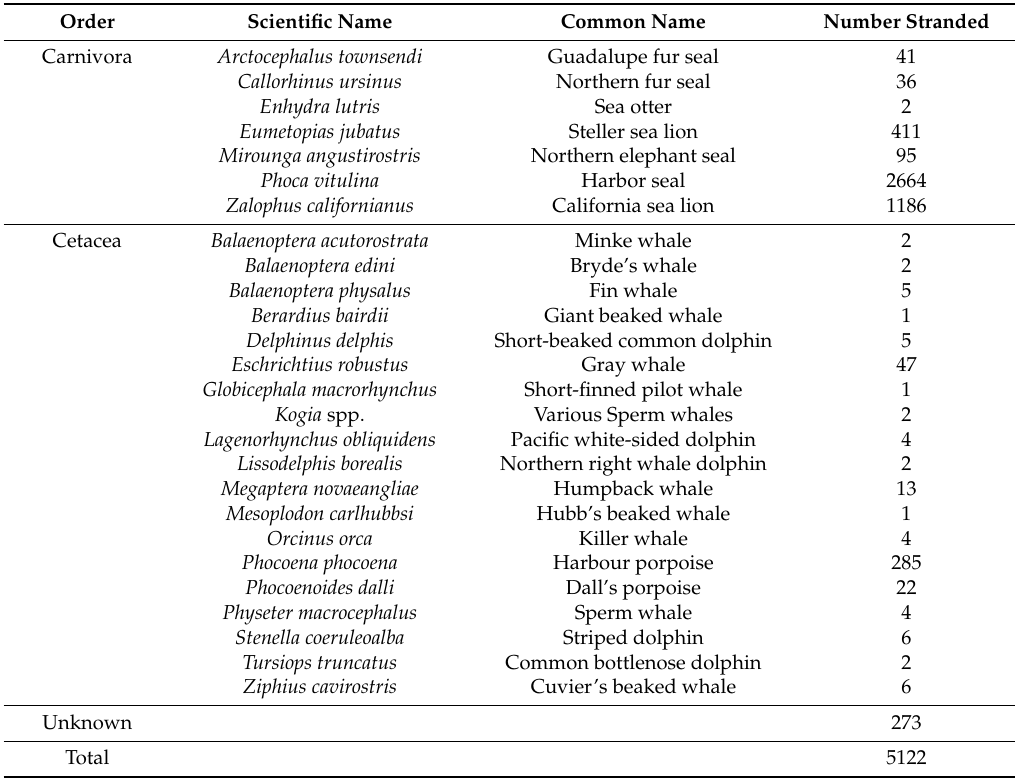
Table 1. The species of marine mammal stranded on the Washington and Oregon coasts from 2005 to